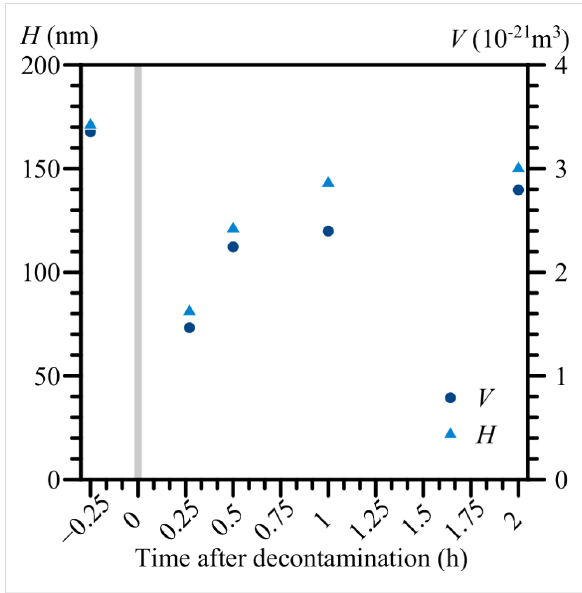
Figure 6: The volume and height of the nanostructures on an Ag sur- face as functions of time following chamber decontamination by nitrogen plasma cleaning. Constant EB parameters are: U = 30 kV, I = 55 pA, d = 14 nm, t = 30 s, and α = 0°.